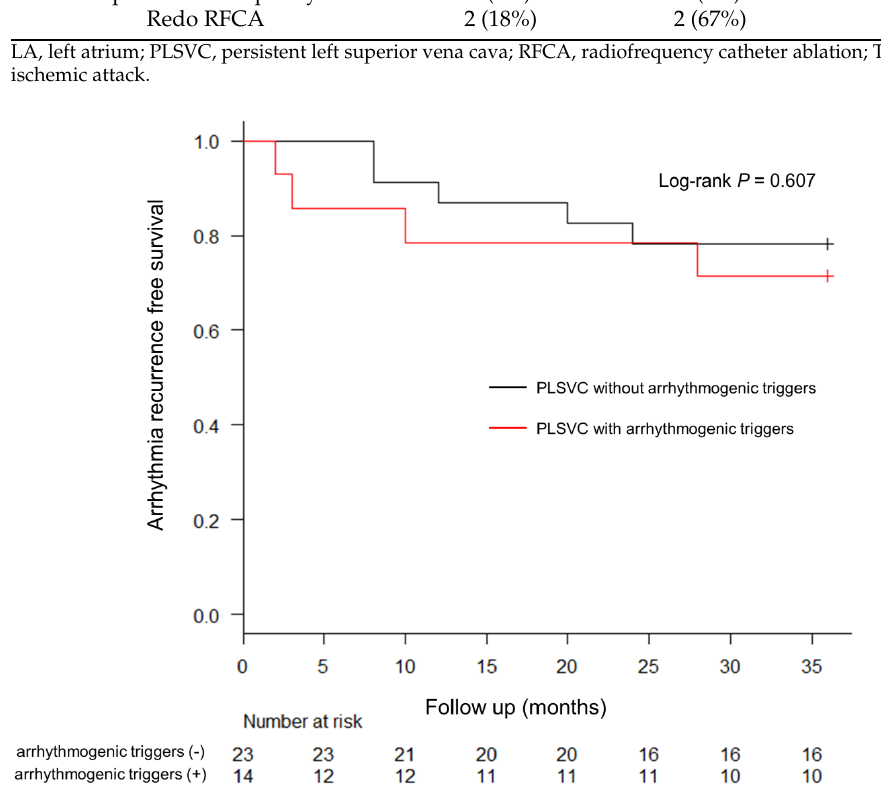
Figure 5. Kaplan-Meier Estimates of 3-Year Freedom from Atrial Arrhythmia Recurrence. The recurrence of atrial arrhythmia in both groups after the last ablation procedure is shown. The electrical isolation of PLSVC was determined based on the electrophysiological study for the provocation of arrhythmogenic triggers initiating AF. No significant difference in arrhythmia recurrence was observed between the two groups. PLSVC, persistent left superior vena cava; AF, atrial fibrillation.